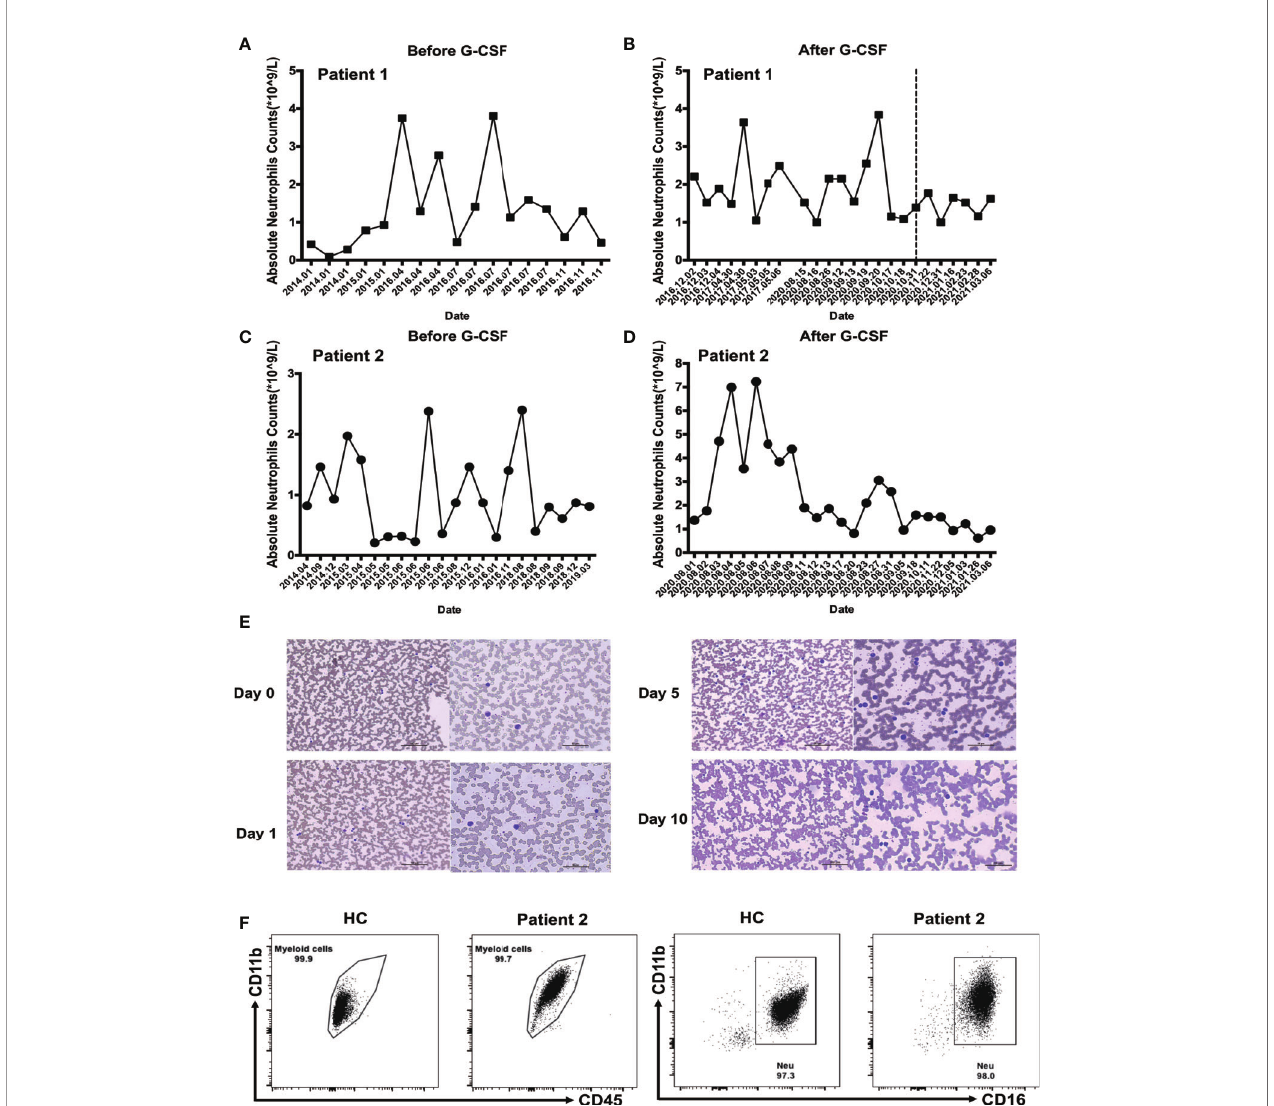
FIGURE 1 | Neutrophil counts before and after granulocyte colony-stimulating factor (G-CSF) treatment. (A) Neutrophil count in patient 1 before G-CSF treatment. (B) Neutrophil count during G-CSF treatment in patient 1; Measurements after discontinuation of G-CSF treatment are shown on the right side of the dotted line. (C) Neutrophil count before G-CSF treatment in patient 2. (D) Neutrophil count during G-CSF treatment in patient 2. (E) Images of peripheral blood samples from patient 2 before and during G-CSF treatment, stained with Wright ’ s stain. (F) Neutrophils dominate Ficoll-Paque enriched SCN4 granulocyte fractions.